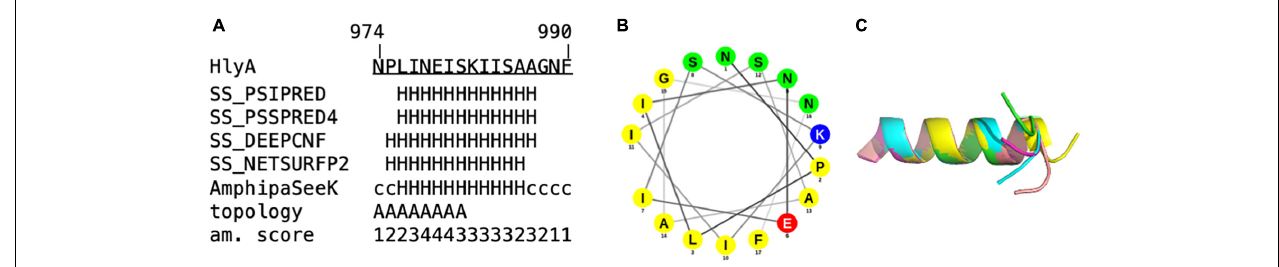
FIGURE 5 | In silico analysis of (A) amino acids 974 to 990 of the secretion signal of HlyA. H = α -helix, c = coiled coil. Predictions labeled with “SS” were obtained from Quick2D, that utilizes multiple prediction algorithms. Topology = predicted by AmphipaSeeK: “A” indicated those residues that are predicted to be inserted parallel into the membrane. Am. score = amphipathy score predicted by AmphipaSeeK with 1 = lowest amphipathy and 5 = highest amphipathy. (B) Helical wheel projection of residue 974–990 of HlyA. Non-polar residues are colored yellow, lysine blue, glutamate red and polar residues green. (C) Superimposition of five PEP-FOLD3 models of residue 974–990 of HlyA. The helix is similar in all five models with the C-terminal tail showing variability in